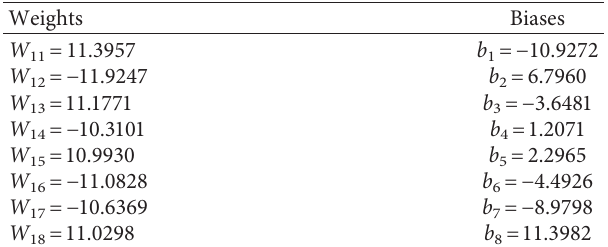
Figure 4: (a) NN training performance; (b) regression between the NN output and the target. Table 4: Optimal set of weights and biases of the